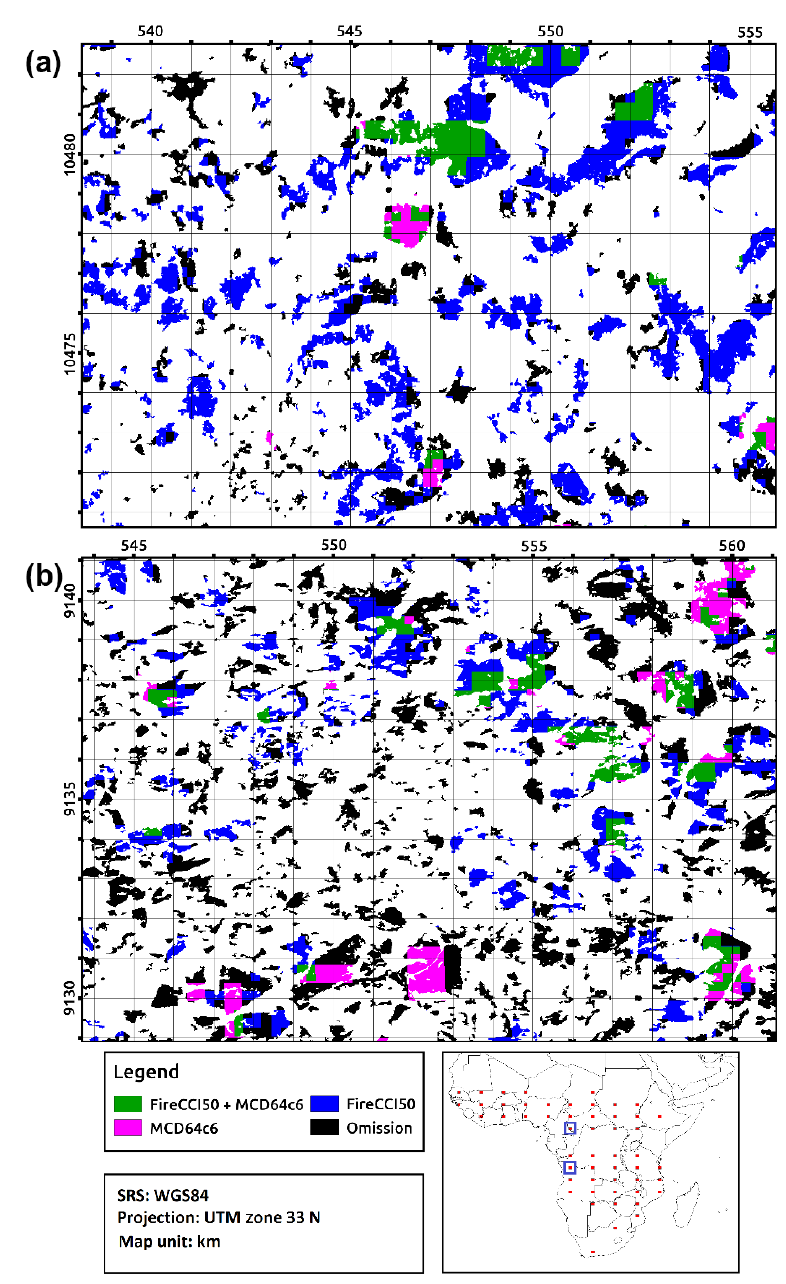
Figure 7. Examples of small fire detections by the FireCCI50 and MCD64A1 c6 products in two Sentinel-2 images located in the west of the Central African Republic (a) and north of Angola (b) . UTM coordinates are included in both maps.